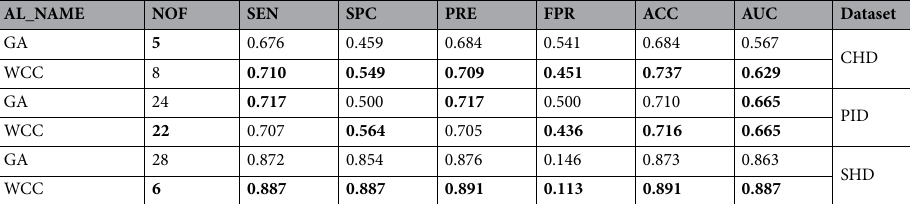
Table 6. Results based on fivefold cross-validation in the second class of obtained data. The best outcomes have been highlighted. NOF, number of features; SEN, sensitivity; SPC, specificity; PRE, precision; FPR, false positive rate; ACC, accuracy; AUC, area under the curve.